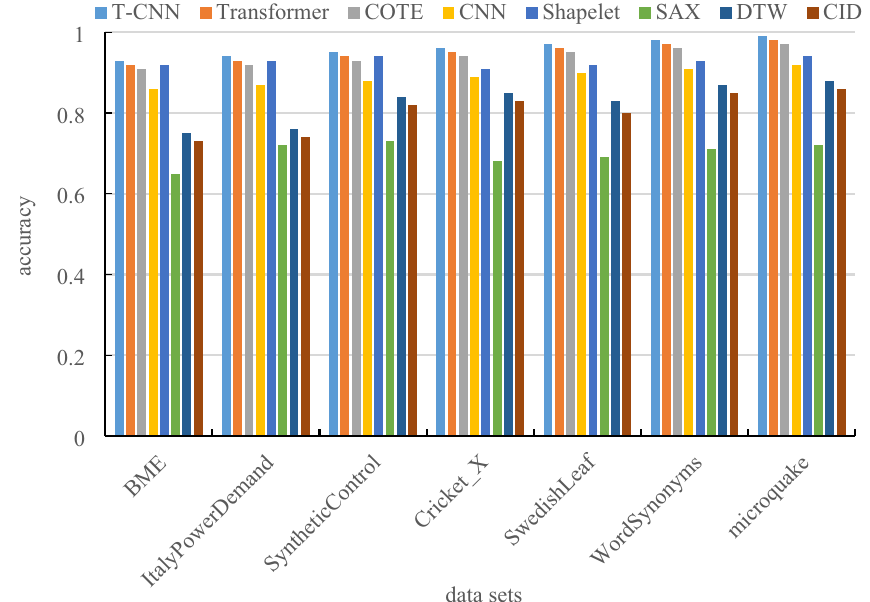
Figure 6. Comparison of classification accuracy.